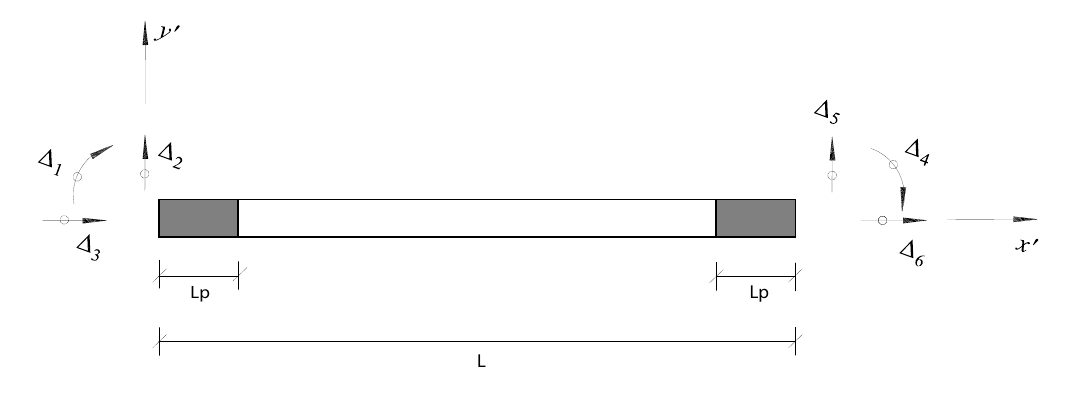
Figure 1. Frame macro-element available in VisualANL.